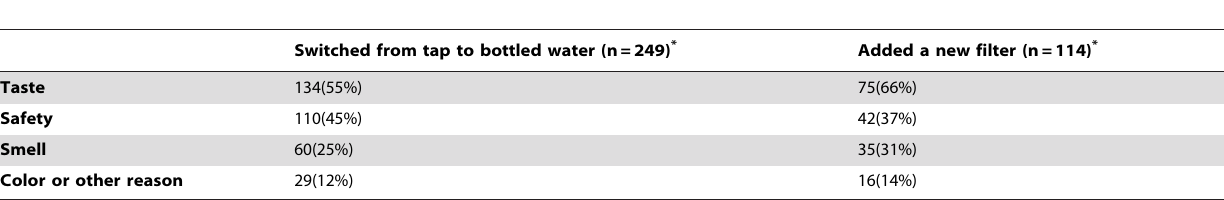
Table 5. Reasons households cited for switching from tap water as a main drinking water source to bottled water as a main drinking water source (n=249) or installing a new water filter (n= 114) after an outbreak of salmonellosis, Alamosa, Colorado 2008.